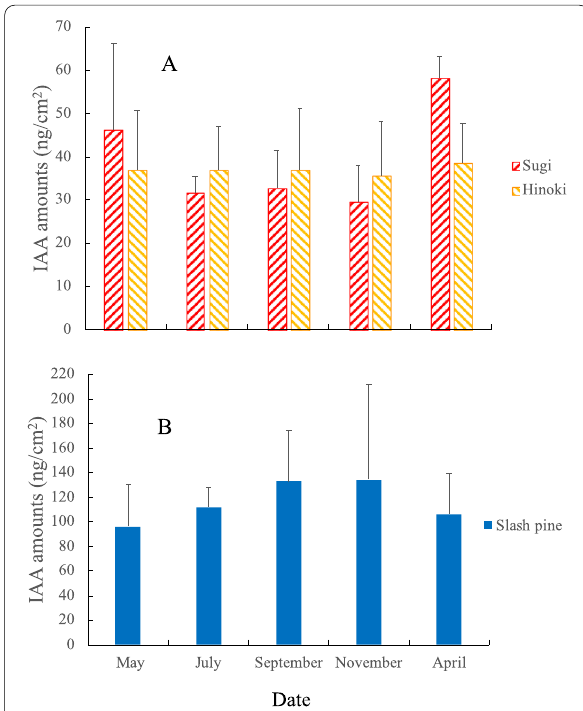
Fig. 4 Seasonal variation of GA4 amounts in three conifers. Data are means SD ( n 3 or ± =